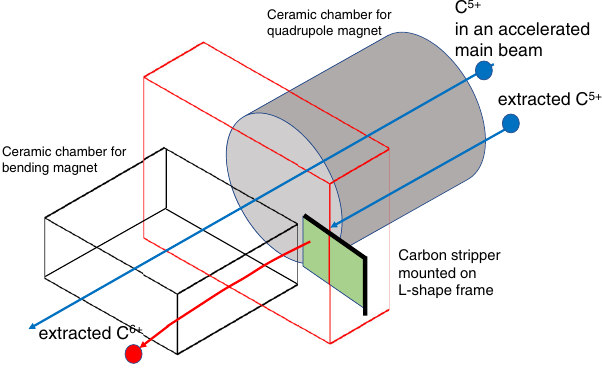
FIG. 10. Stripper foil